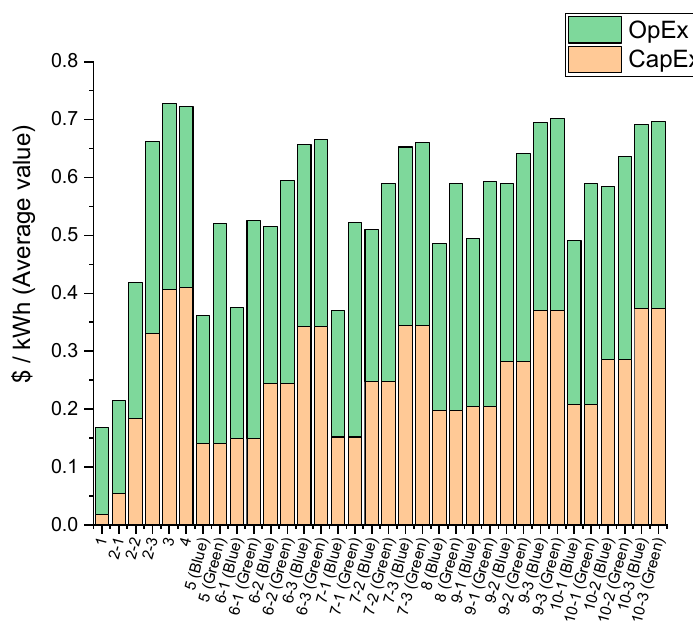
Figure 5. The proportion of capital and operating expenditure to the total cost.